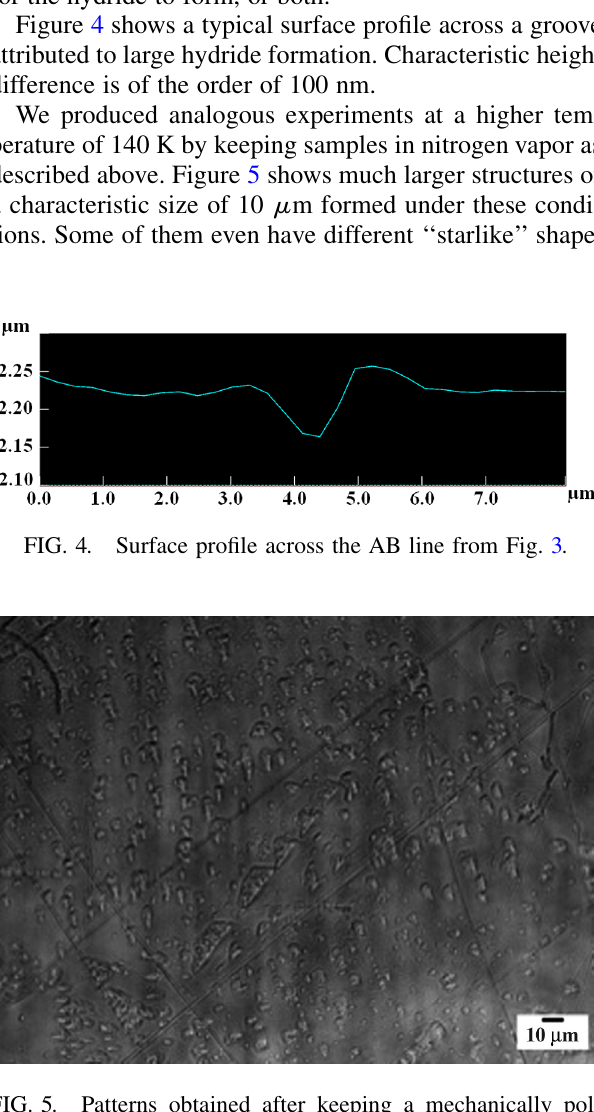
FIG. 5. Patterns obtained after keeping a mechanically pol- ished sample at 140 K for 1